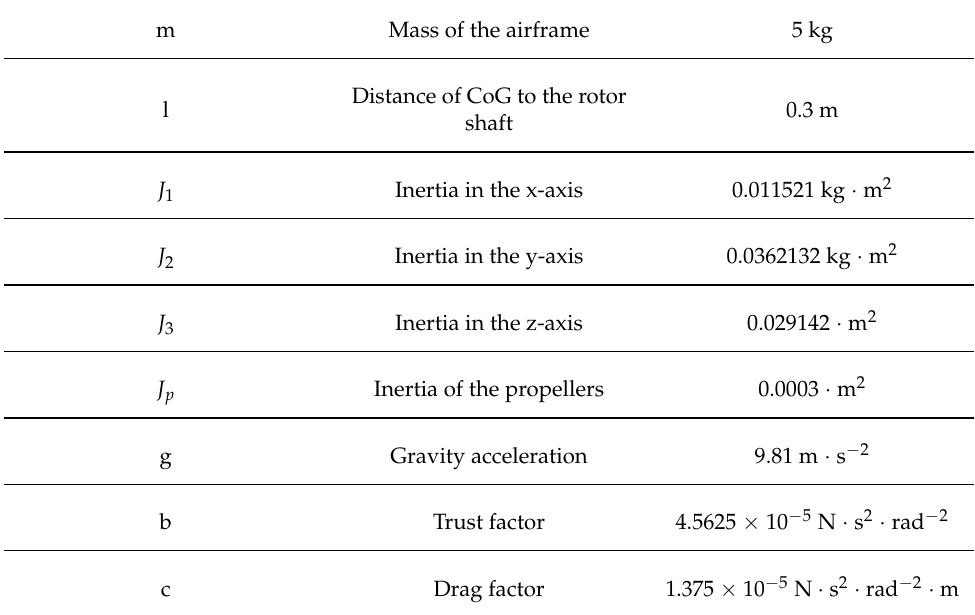
Table 1. Nominal quadrotor